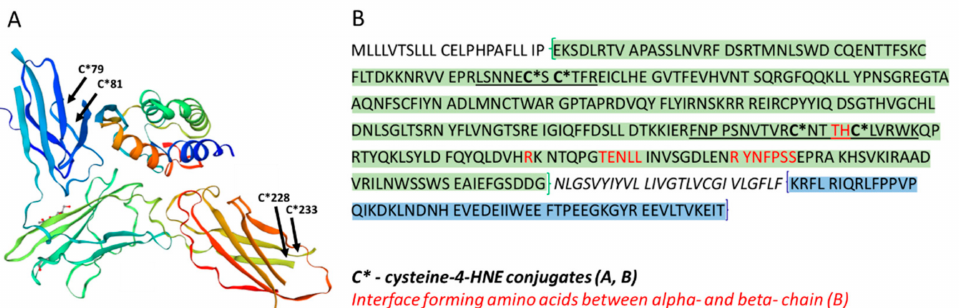
Figure 7. 3D structure and amino acid sequence of the alpha-chain of GM-CSF R (CD 116), the positions of amino acids conjugated with 4-HNE, and proximate amino acids essential for cor- rect receptor function. 3D representation of CD116 fragment 35–315 (available online: https: //swissmodel.expasy.org/repository/uniprot/P15509?template=4rs1 (accessed on 29 July 2021)) with indicated 4-HNE conjugated amino acids ( A ). Full amino acid sequence (1–400) of GM-CSF [47] with 4-HNE-conjugated cysteine residues in bold and labelled by * (C*), and underlined 4-HNE- modified peptides detected after trypsin digestion. In red are the interface-forming amino acids between alpha- and beta-chain, described as site 3 [48], the hydrophobic interface with rim of charged residues. Site 3 interacting surface enhanced GM-CSF R binding affinity to GM-CSF. The extracellular domain of receptor is evidenced in green, the intracellular domain in blue ( B